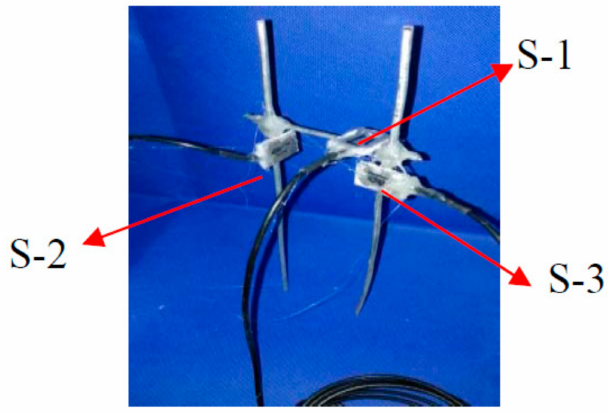
Figure 4. The configuration of sensors prior to embedment.